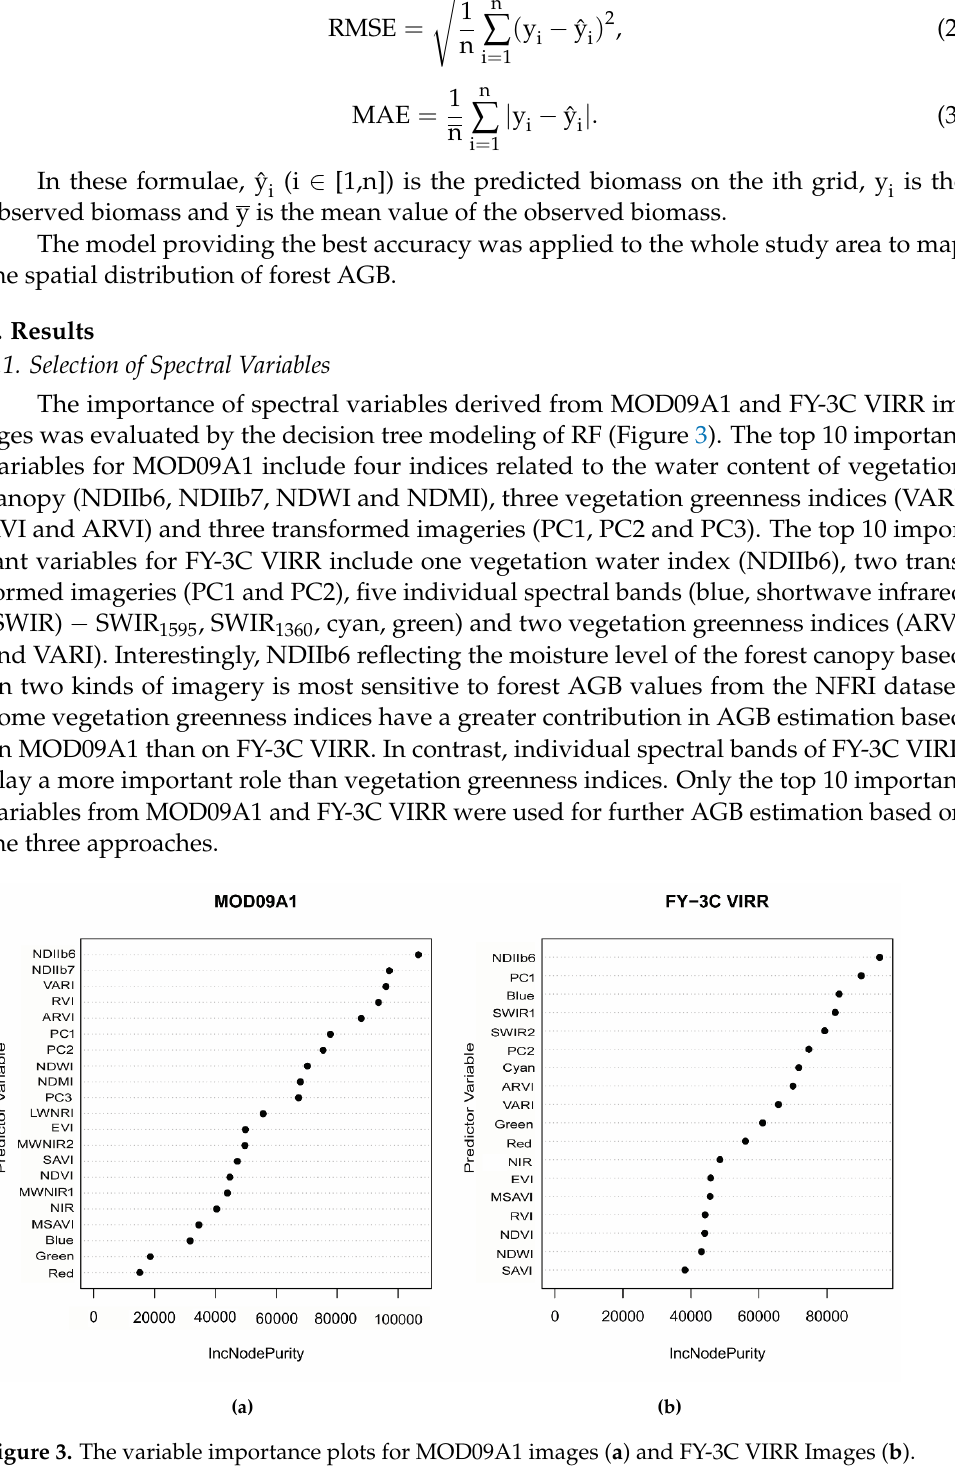
Figure 3. The variable importance plots for MOD09A1 images ( a ) and FY-3C VIRR Images ( b ).